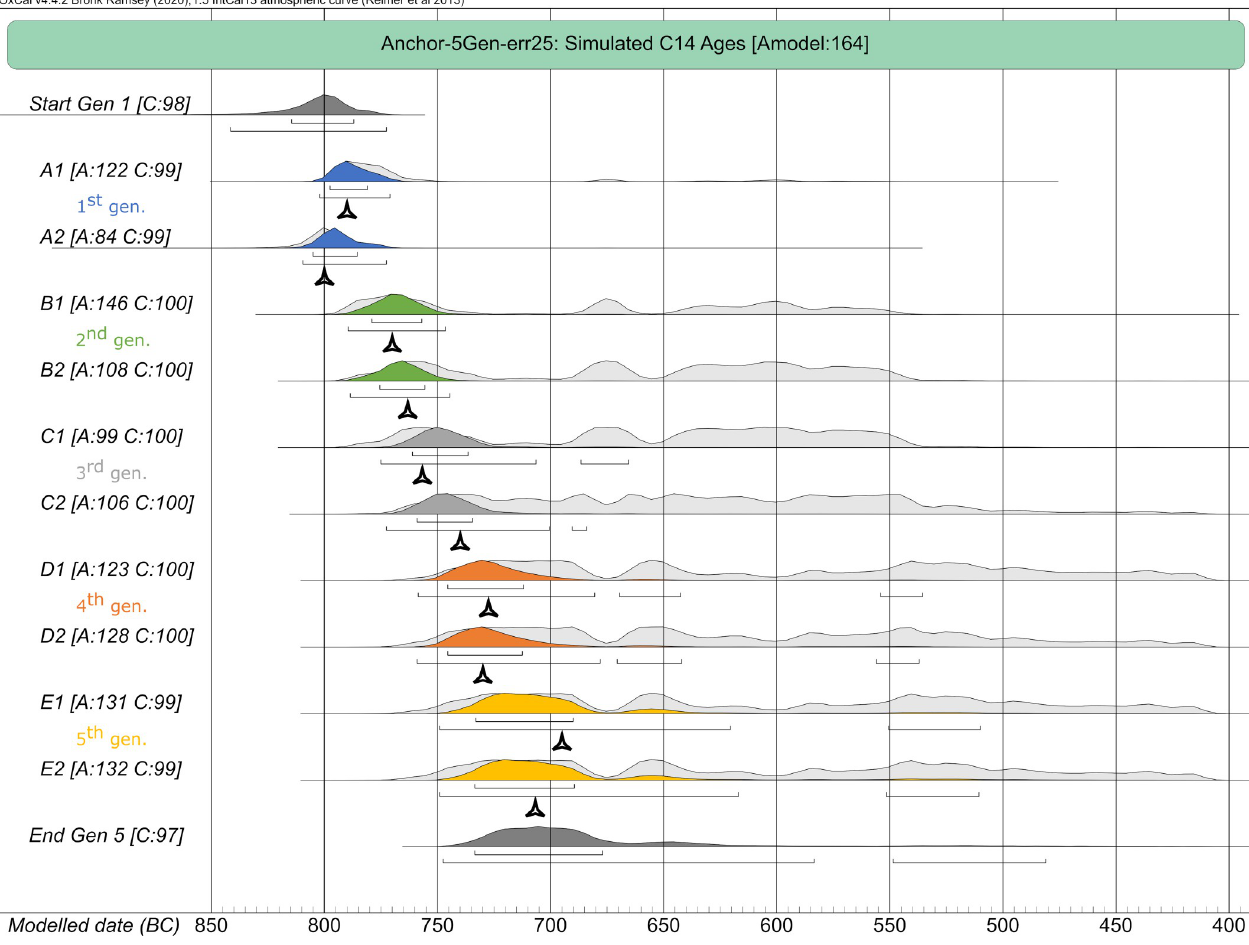
Fig 17. Plot of the five-generation Bayesian simulation with unmodelled and modelled dating range probabilities. (light grey) unmodelled probabilities; (coloured) modelled probabilities. Brackets underneath the probability ranges represent 2-sigma ranges of the modelled dates. Black triangles represent given/ prescribed years of death